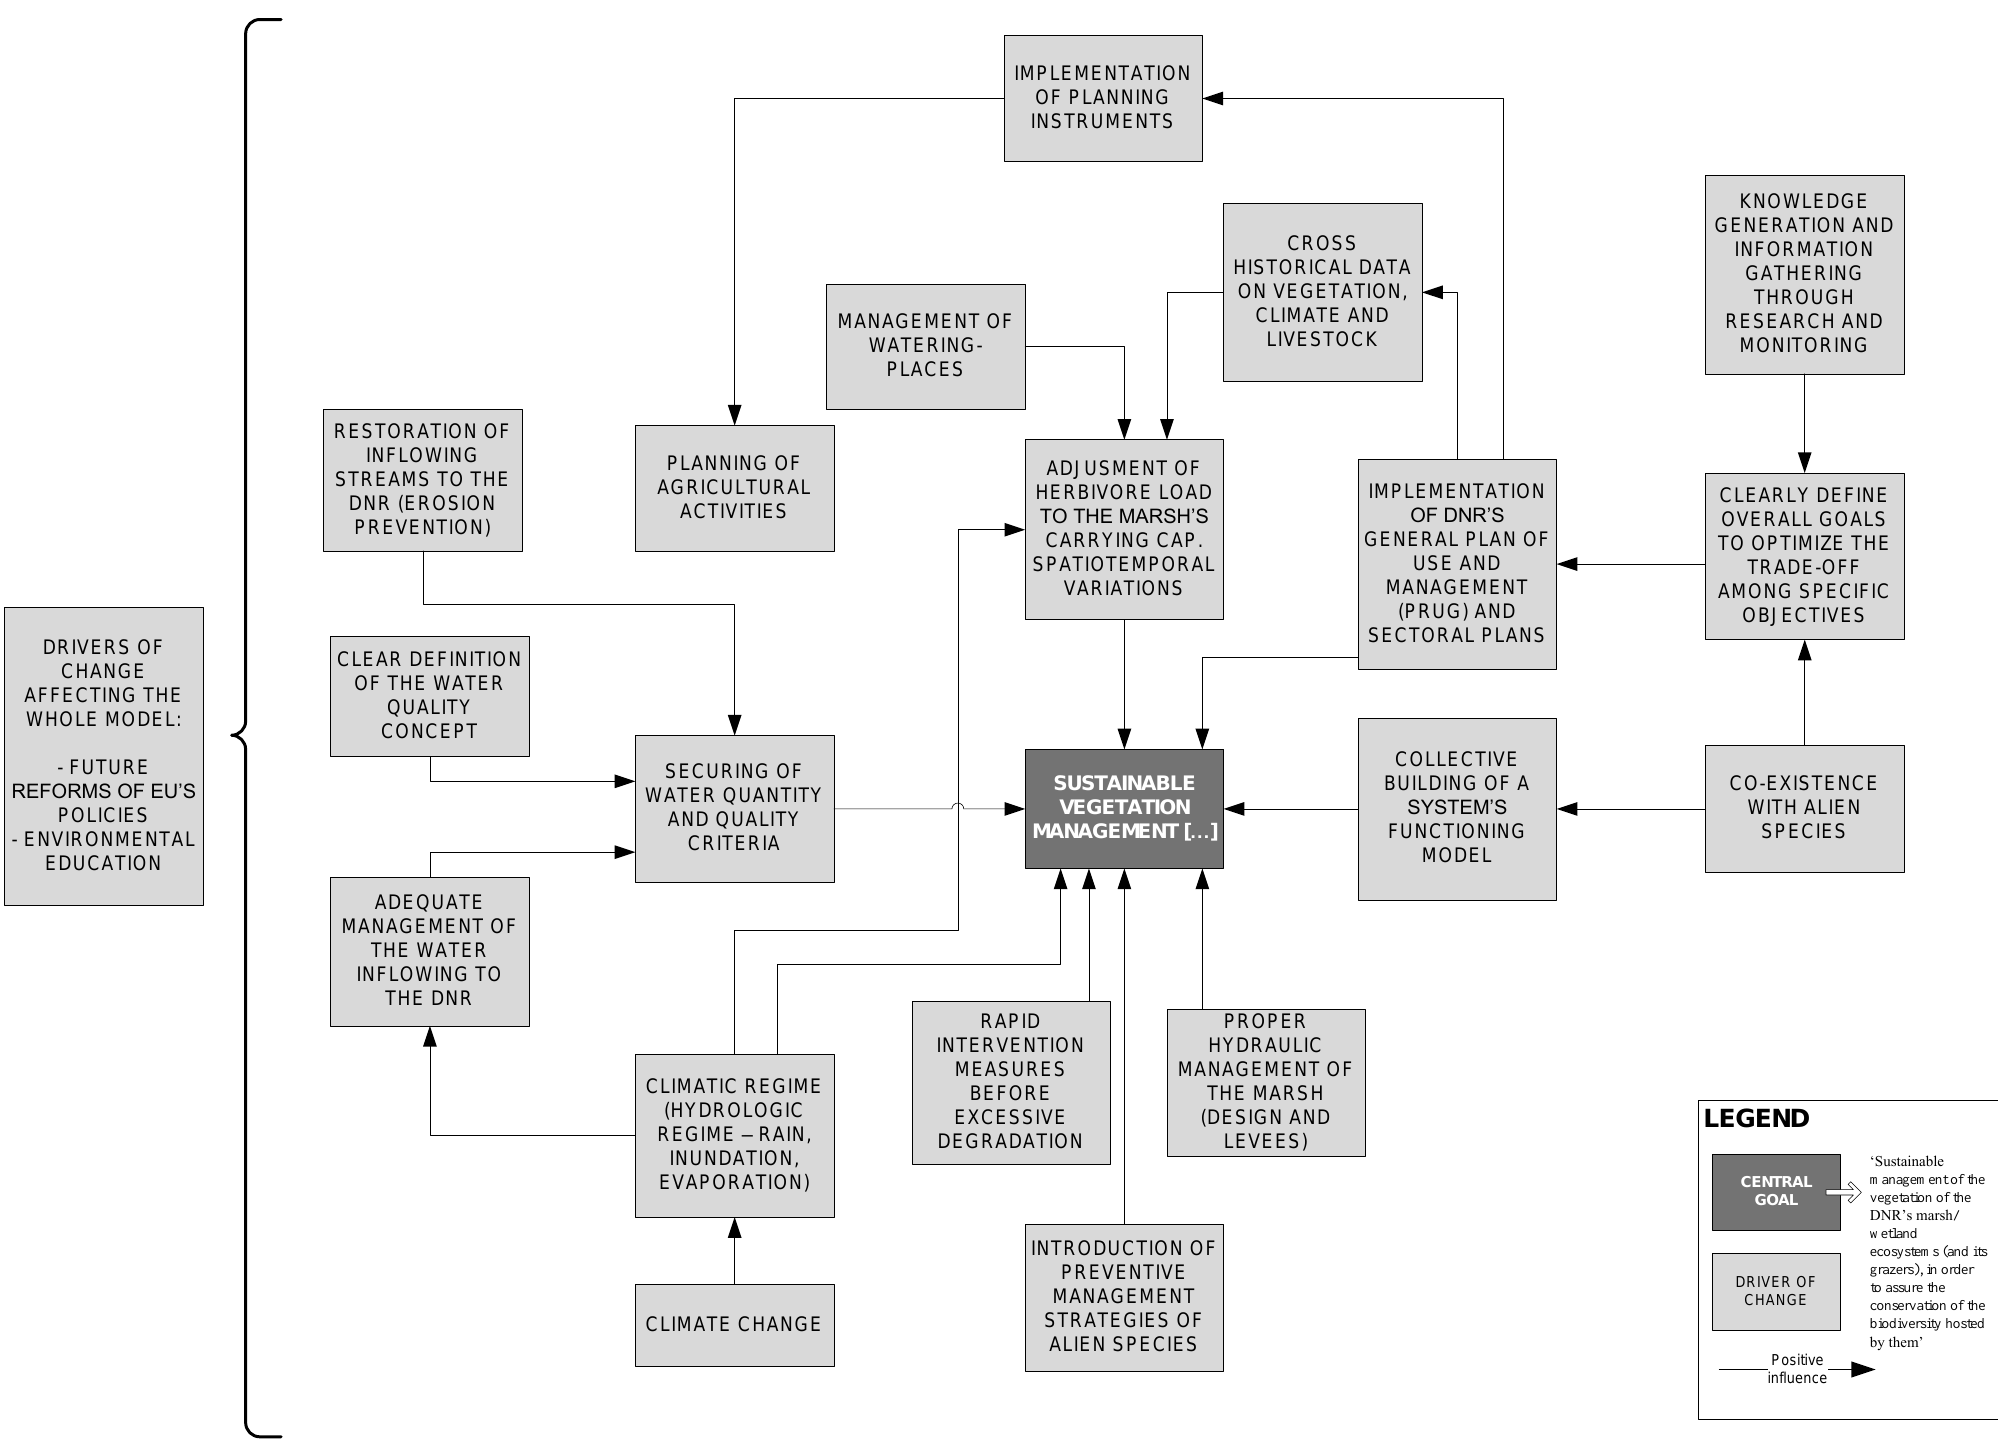
Fig. A2.2. Vegetation-management